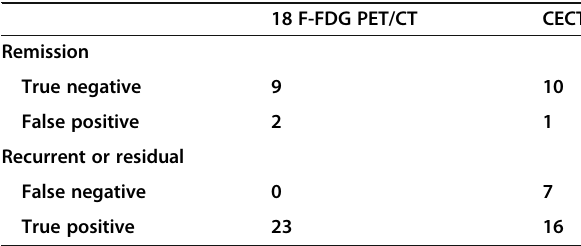
Table 3 Group B ( n =34) follow-up imaging results (correlation with final